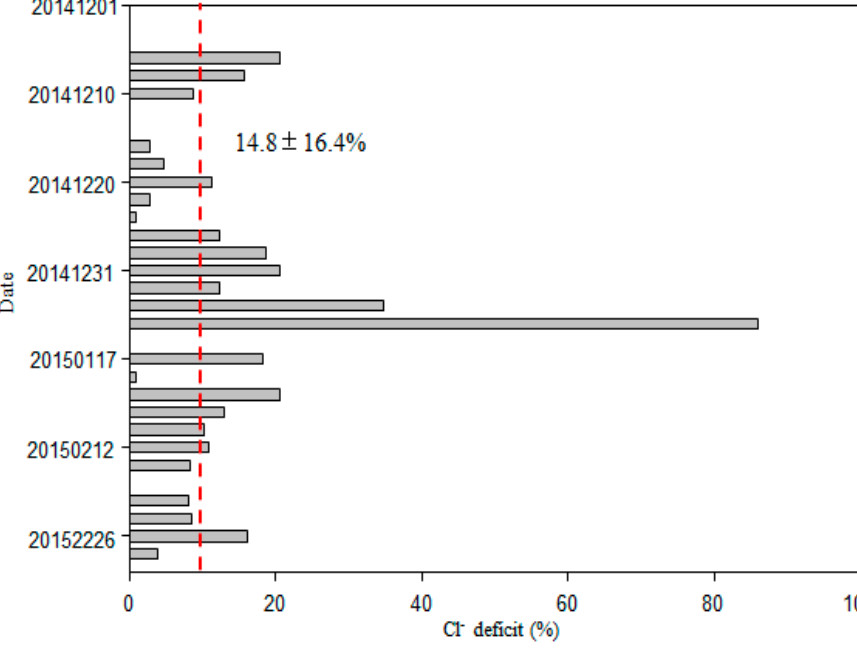
Figure 6. ( a ) nss- and ss-SO 42 − , ( b ) nss- and ss-Ca 2+ , ( c ) nss- and ss-K + , and ( d ) nss- and ss-Mg 2+ at different sites over the western North Pacific.